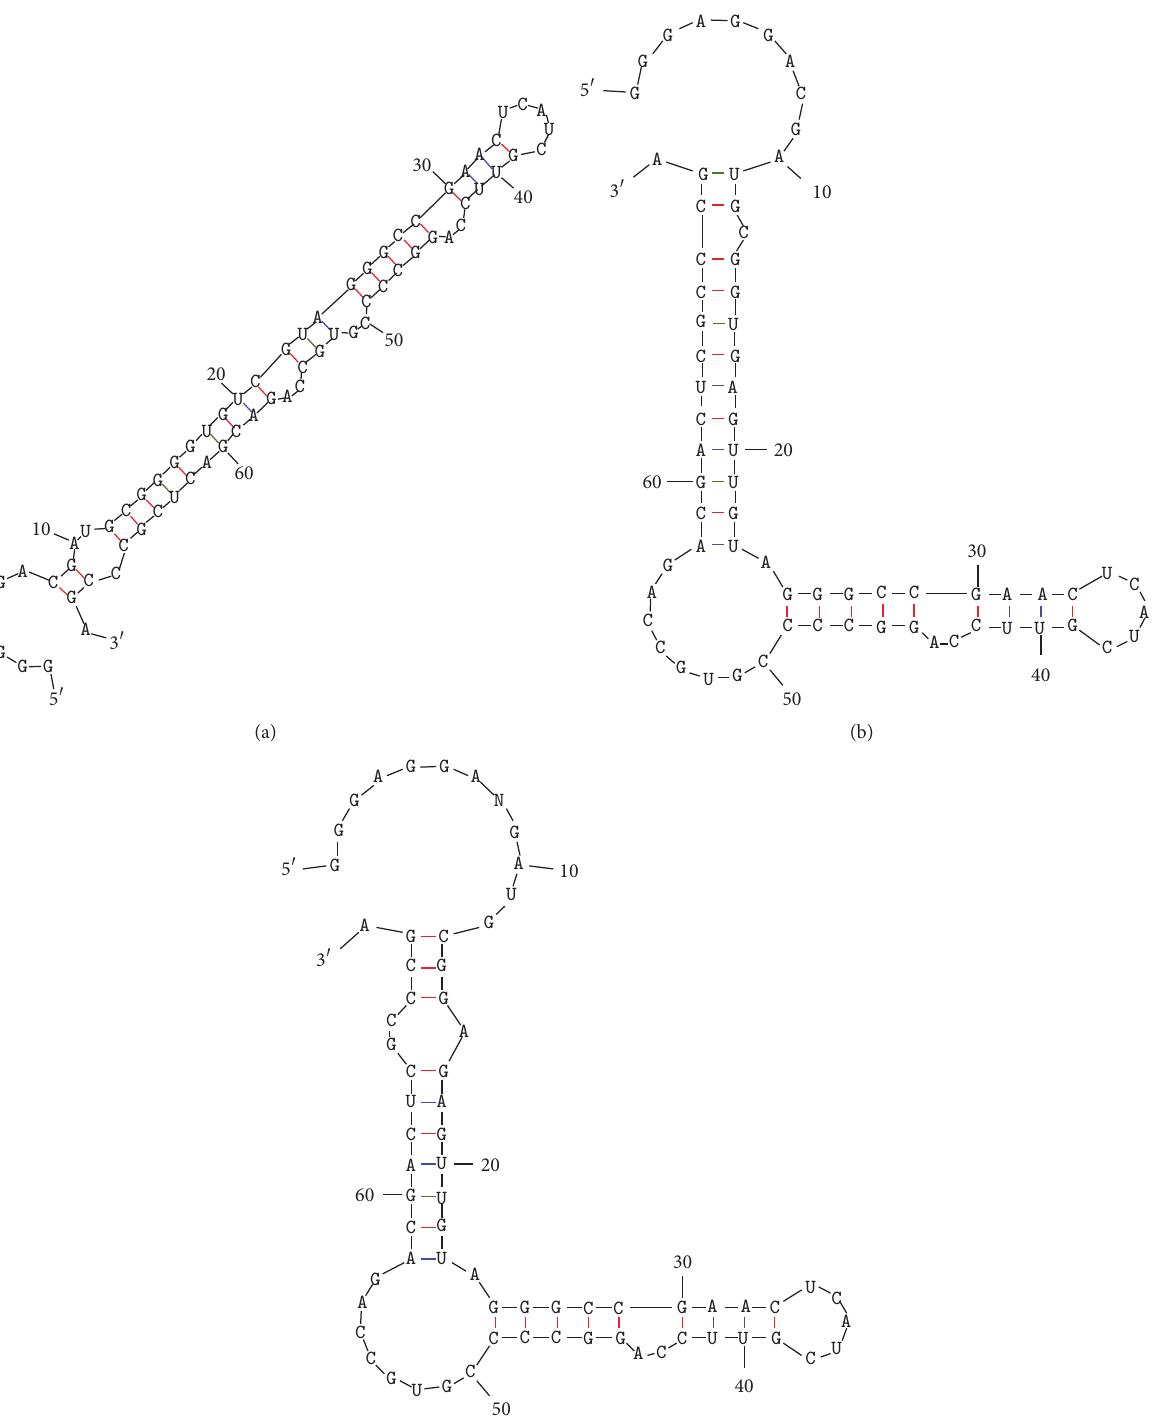
percentage enrichment of the SELEX rounds (Figure